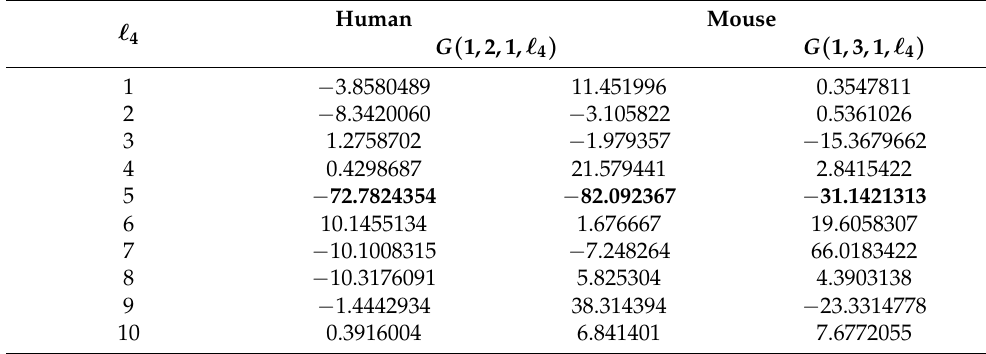
Table 3. G ( 1,2,1, (cid:96) 4 ) for human and mouse and G ( 1,3,1, (cid:96) 4 ) only for mice obtained by applying